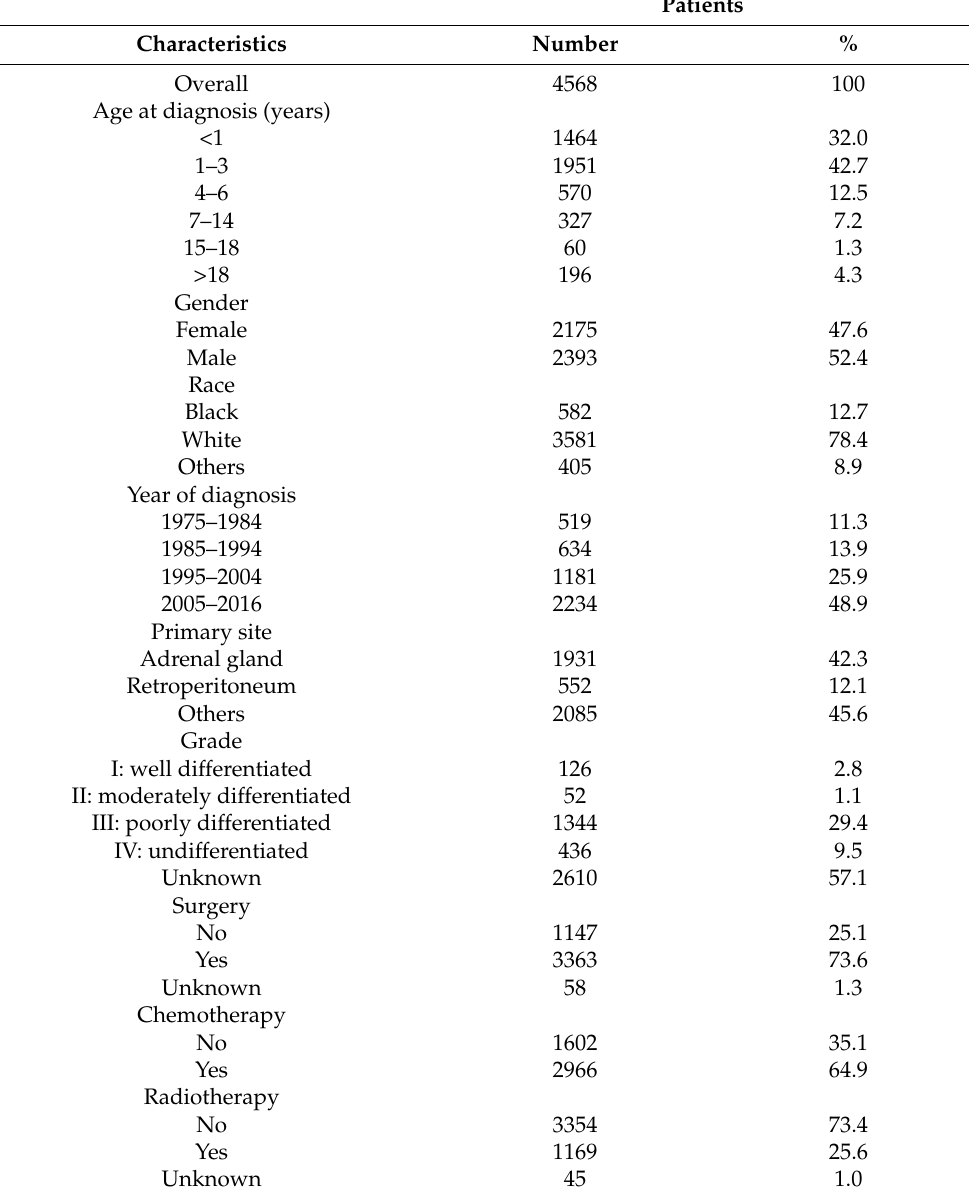
Table 2. Characteristics of the NB patients and received treatments in the SEER program (1975–2016).